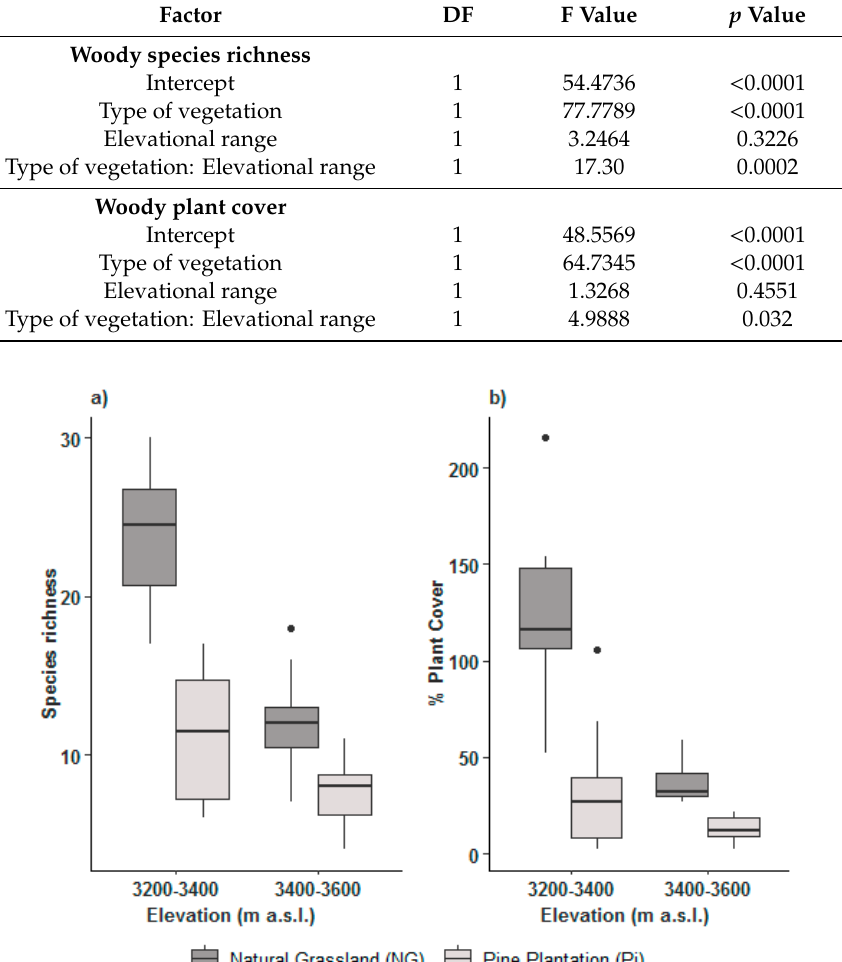
Figure 3. Box plots for the effects of elevational range (3200–3400 and 3400–3600 m a.s.l.) and type of vegetation (Pi and NG) on ( a ) woody species richness and ( b ) woody plant cover. Table 3. Influence of elevational range and type of vegetation on species richness and plant cover of woody vegetation according to an ANOVA analysis obtained from the linear mixed model